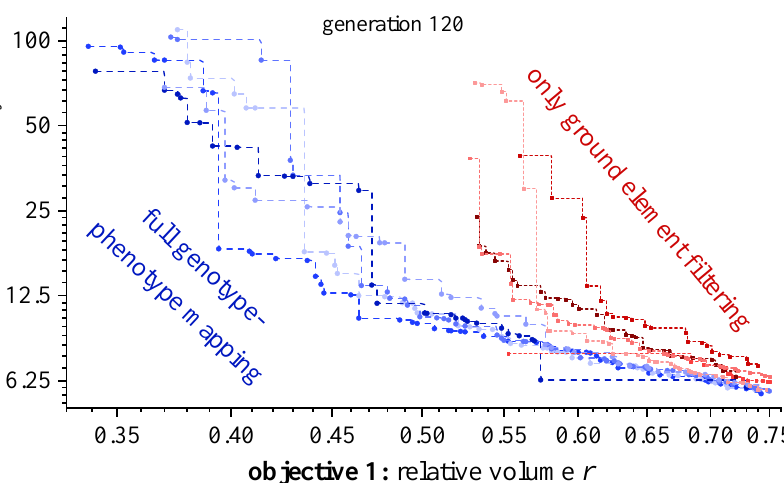
Figure 8. Optimization results to the problem given in Figure 7 in objective space. Shown are sets of results from five independent optimization runs each with the presented genotype-phenotype mapping enabled (blue) or only ground element filtering (red) enabled. Each line corresponds to the Pareto front of a single optimization with the dots indicating single non-dominated